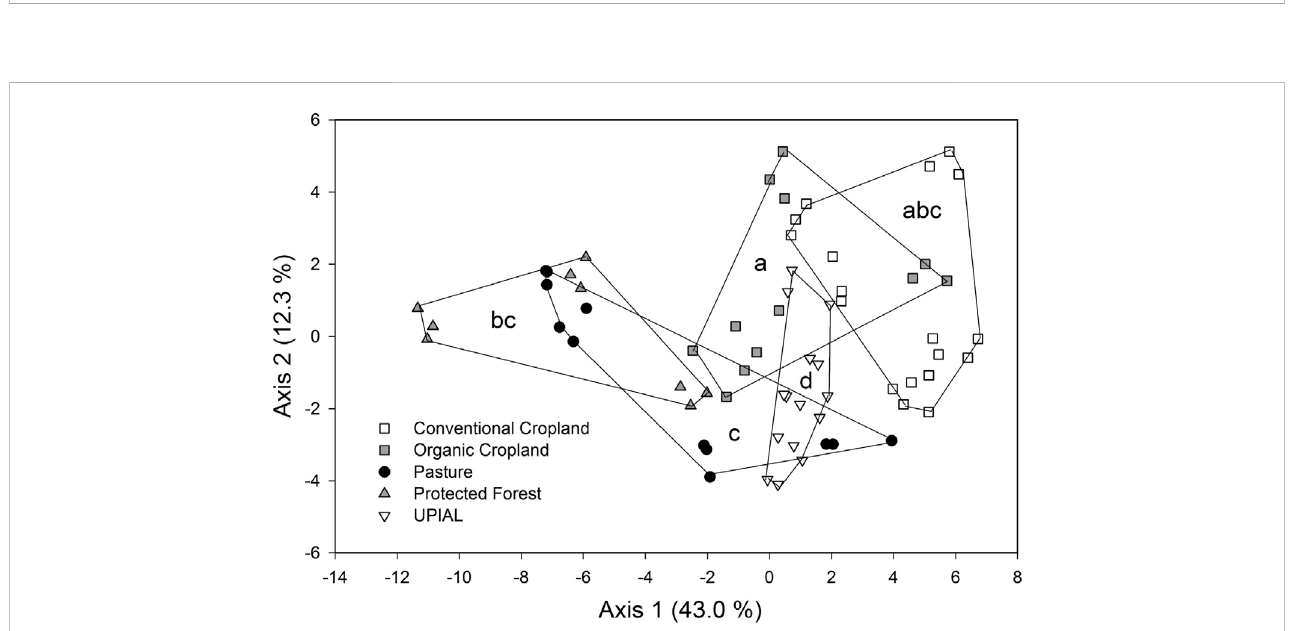
FIGURE 4 Axes 1 and 2 of the principal components analysis for all potential soil health indicators including the multi-response permutation procedures results comparing the multivariate within and between group testing among the current land uses. Conventional cropland (white square), organic cropland (grey square),pasture(blackcircle),protectedforest(greytriangle),orunmanagedpreviouslyintensiveagriculture(UPIAL,upsidedownwhitetriangle).Theamount of variability explained by each axis is in parentheses. Groups with different letters have statistically greater similarity within the group than to others in multivariate